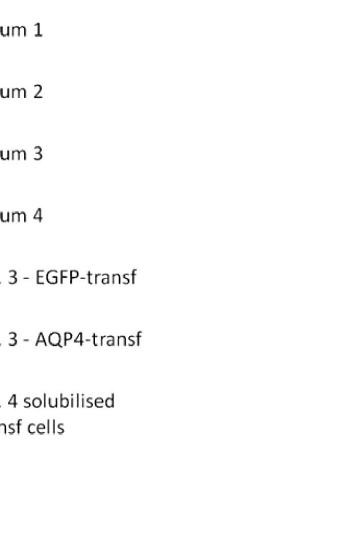
Figure 8. Determination of the percentage of antibodies directed against the extracellular domain of membrane-embedded AQP1. Four anti-AQP1-positive sera were left untreated or were preincubated with increasing numbers of AQP1-GFP- (filled symbols) or EGFP-transfected (shown only for serum 3; empty triangle) HEK293 cells treated with secretin to increase surface expression of AQP1; the untreated and treated samples were tested in the usual RIPA for anti-AQP1 antibodies. The sera were also treated with AQP4-transfected HEK293 cells (shown only for serum 3; open circle). Serum 4 was also treated with an extract of AQP1-transfected HEK293 cells (open square).